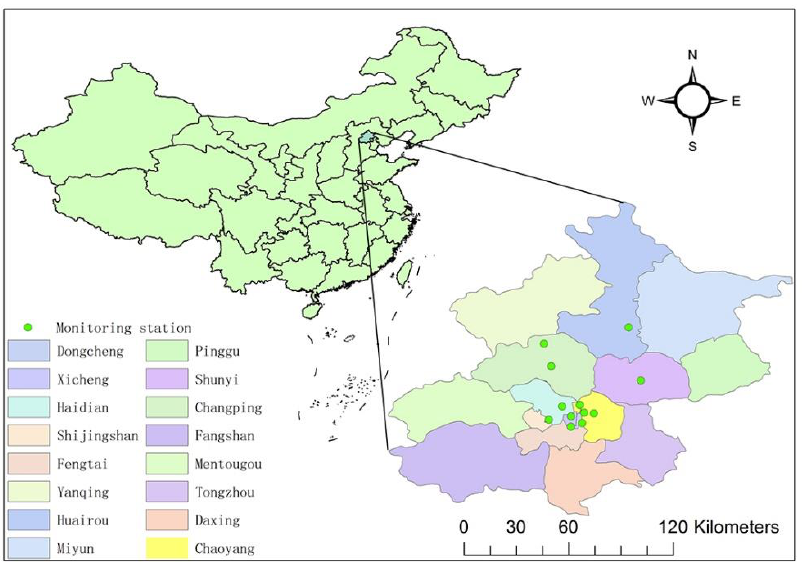
Figure 1. Locations of the study areas within China and the air quality monitoring stations.